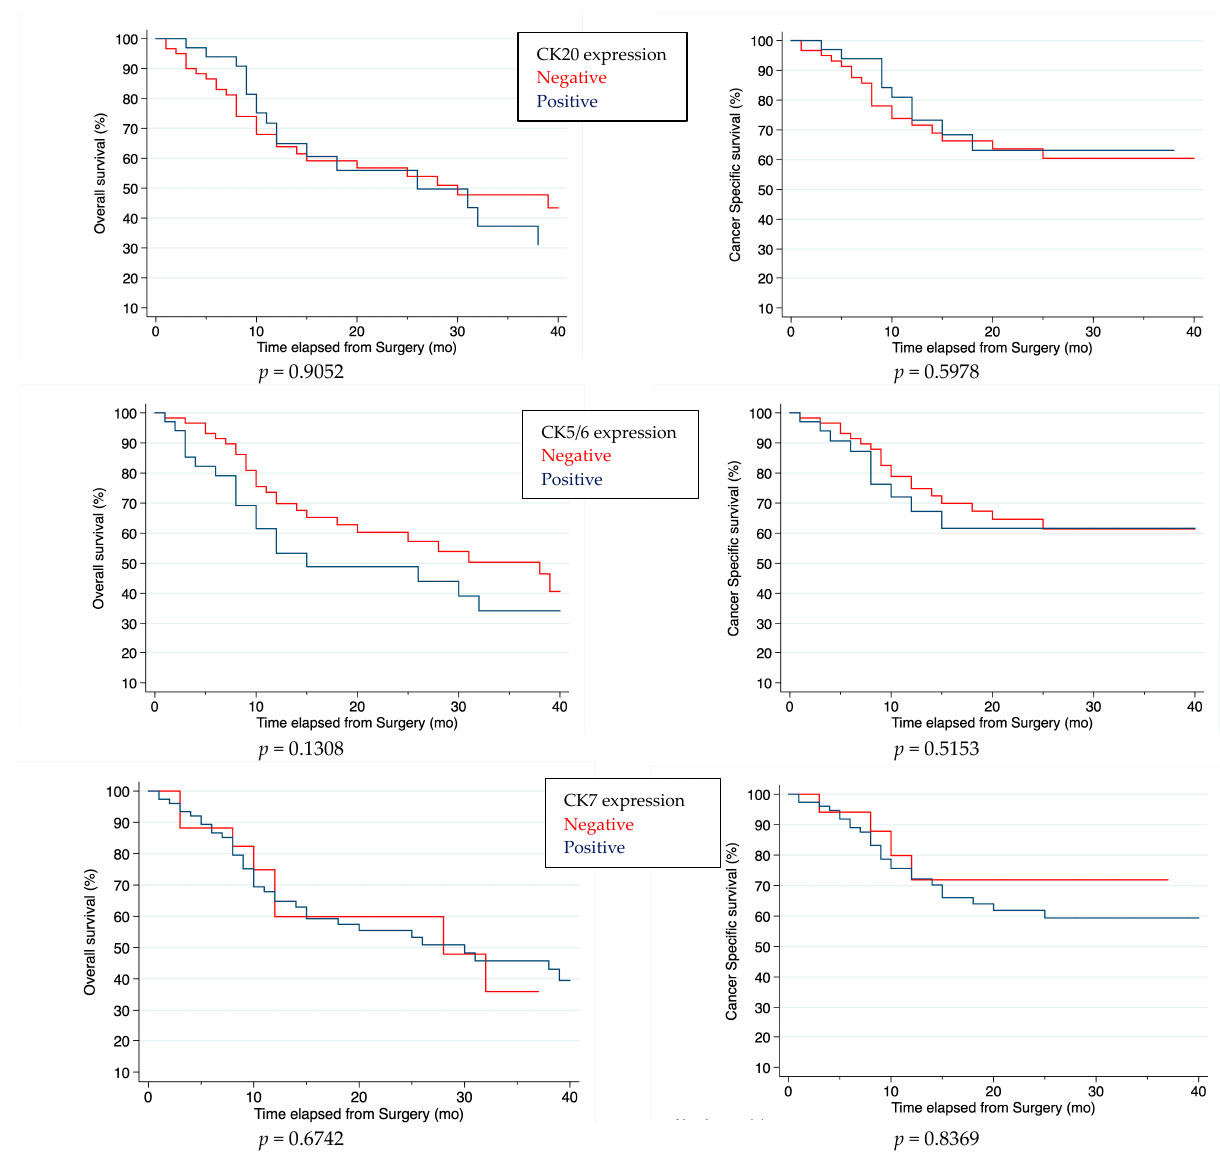
Figure 1. Venn diagram showing the expression of the 1 basal (CK5/6) and 2 luminal (CK20, GATA3) markers analyzed in this study. The relationships between the two schemes are summarized in the contingency table.